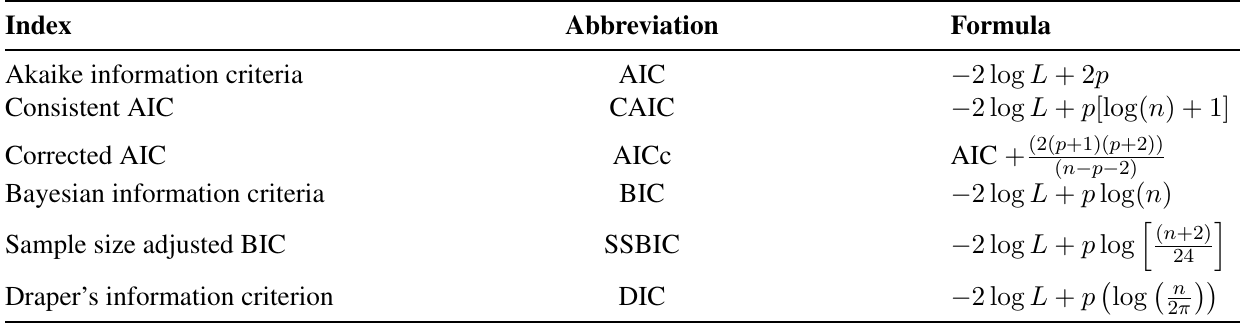
Table 3. Information-theoretic fit